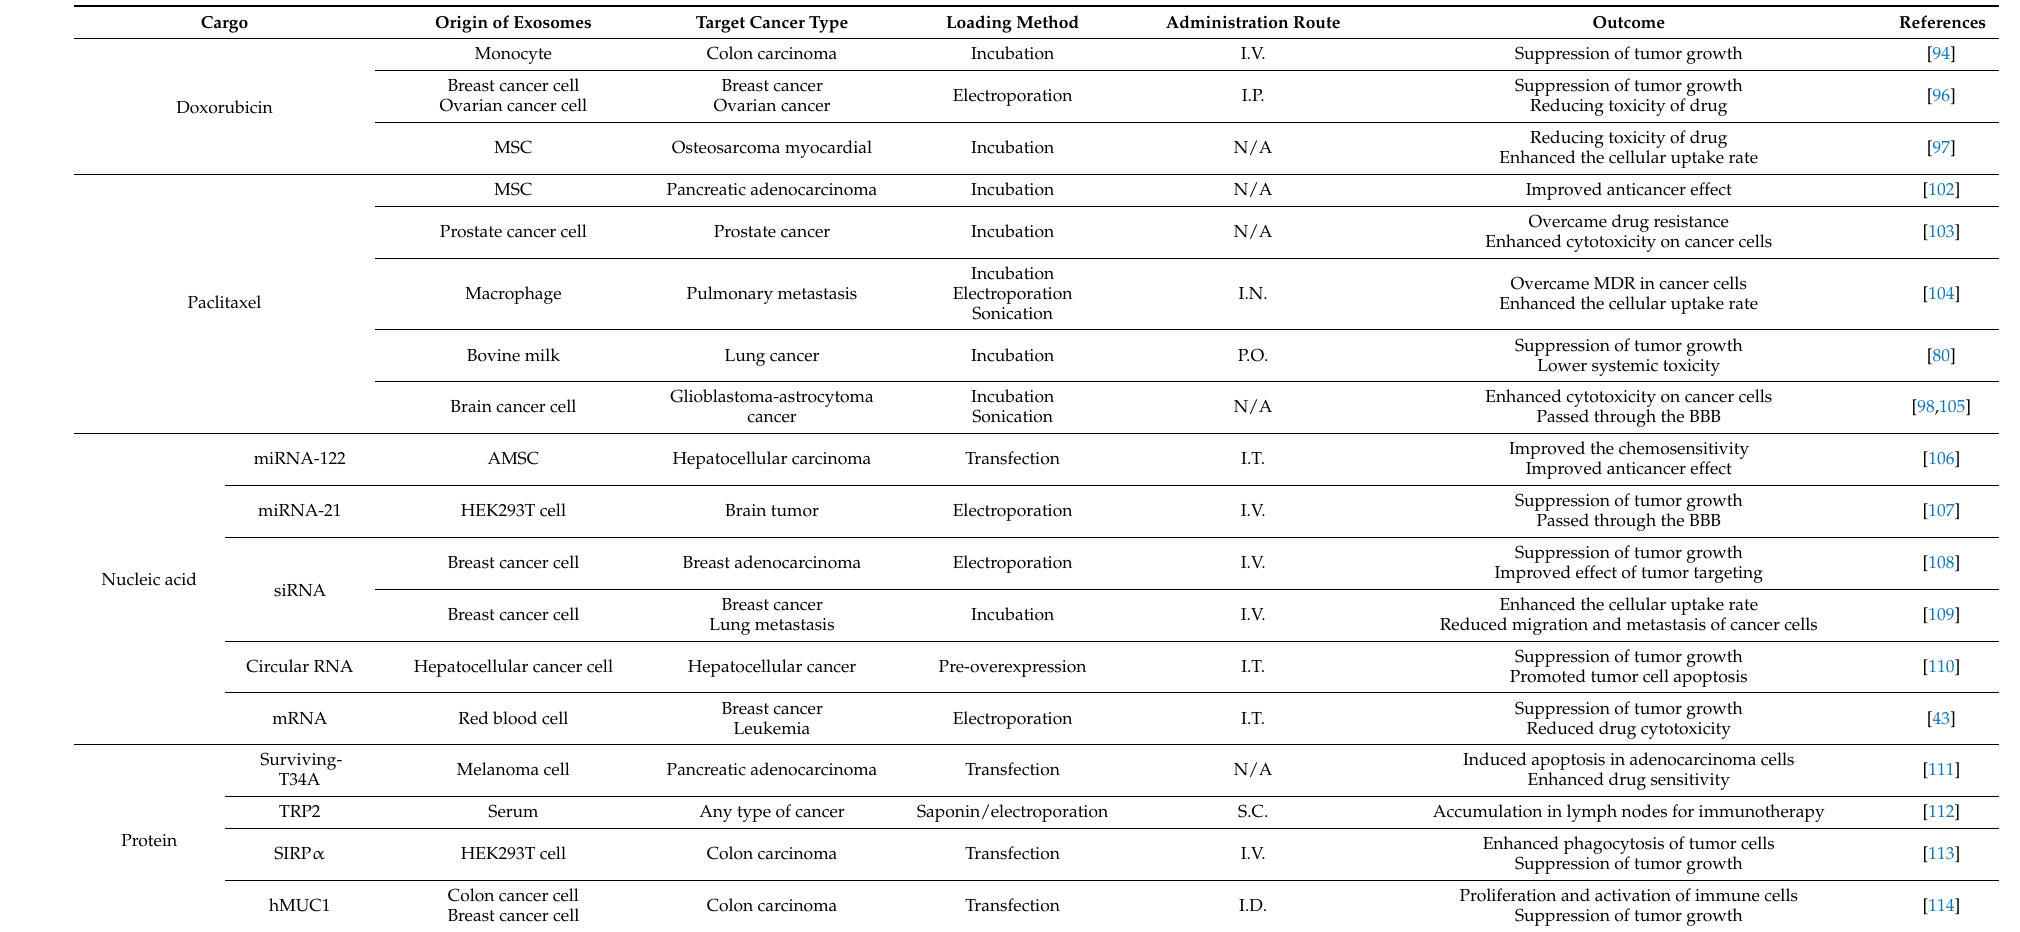
Table 2. Exosome cargo loading for cancer